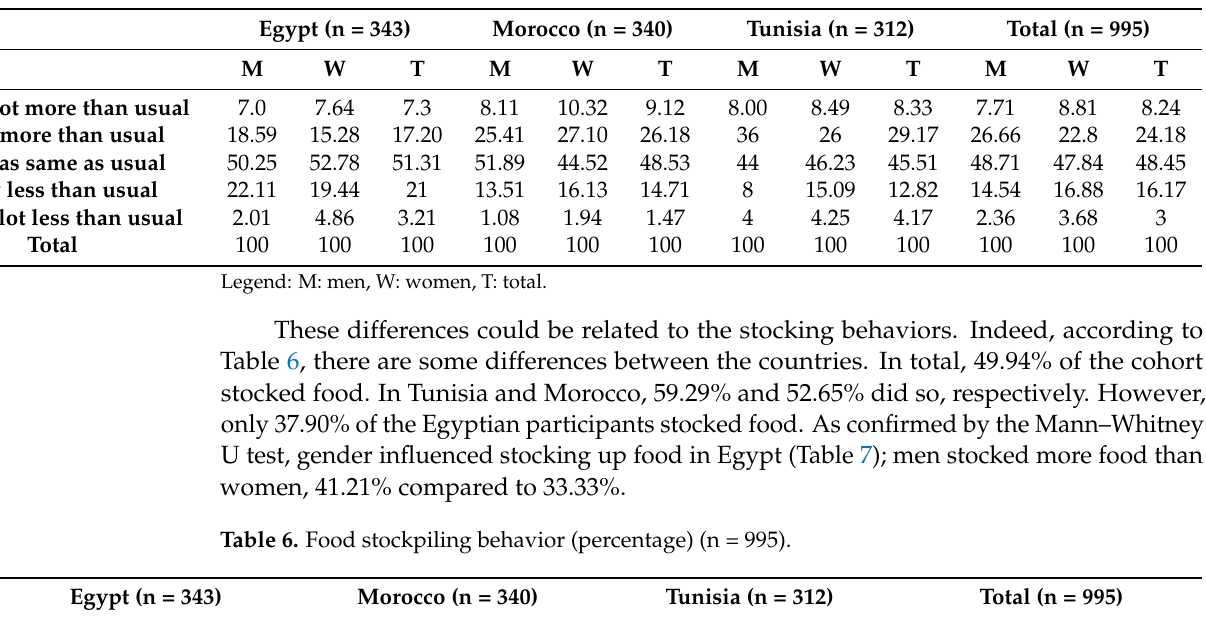
Table 5. Change in food purchase behavior (percentage) (n = 995).